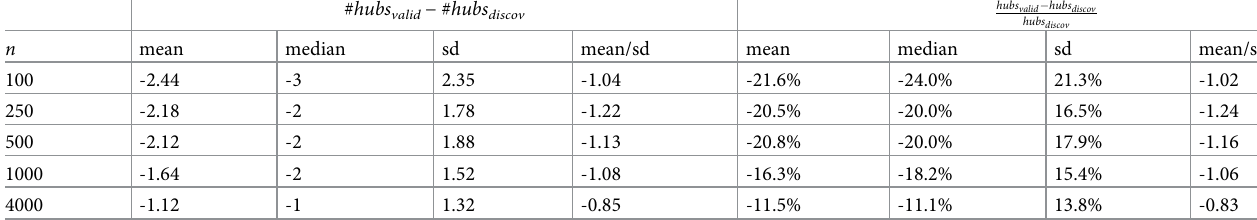
The lines point downwards in most cases, i.e., the results for the validation data are usually slightly worse than for the discovery data. This indicates over-optimism effects. To further